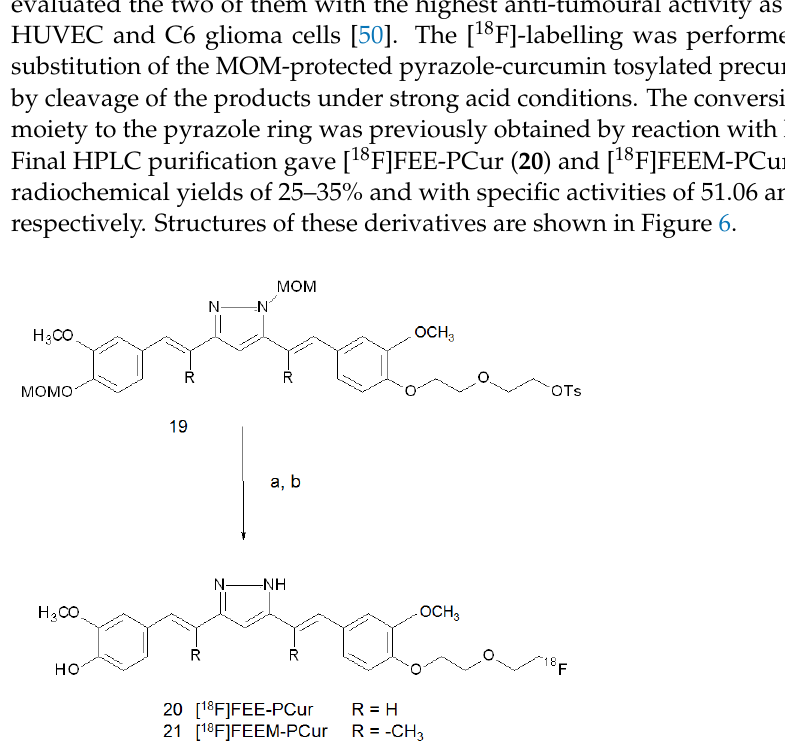
Figure 6. Reagents and conditions: ( a ) n-Bu 4 N[ 18 F]F, CH 3 CN, 110 °C, 10 min; ( b ) 6 N HCl, 120 °C, 10 min.